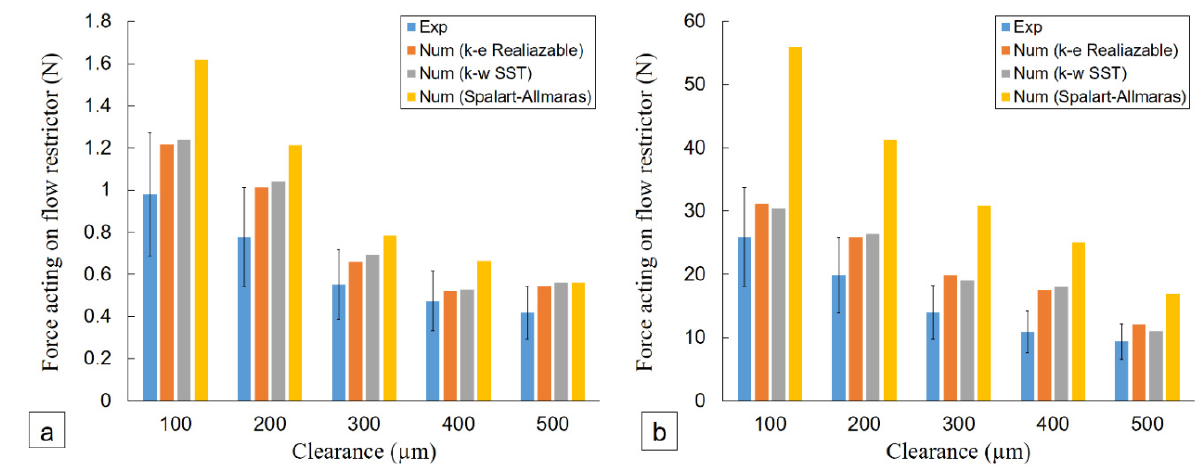
Figure 4. Numerical and experimental results of force analysis for needle draft angle of 15° at ( a ) inlet pressure of 10 bar and ( b ) inlet pressure of 50 bar.